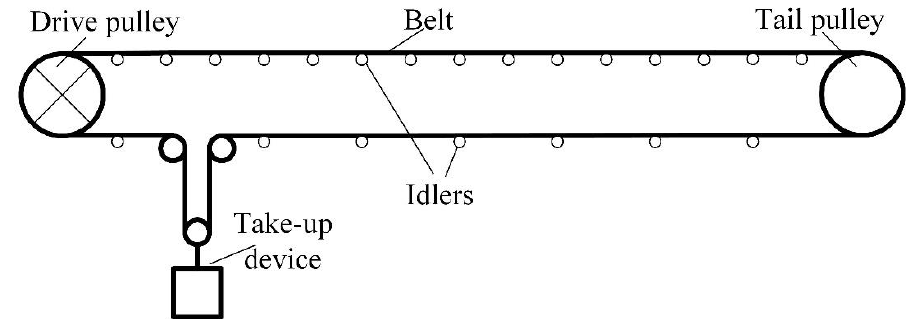
Figure 1. Belt conveyor assembly.